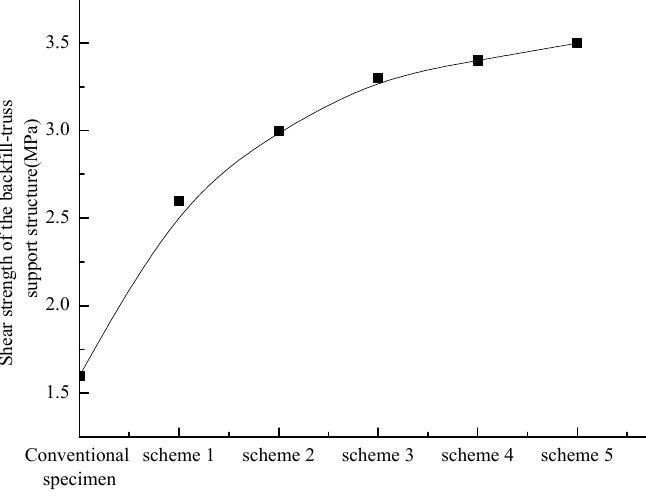
Figure 13. Results of direct shear test of backfill–truss support structure.